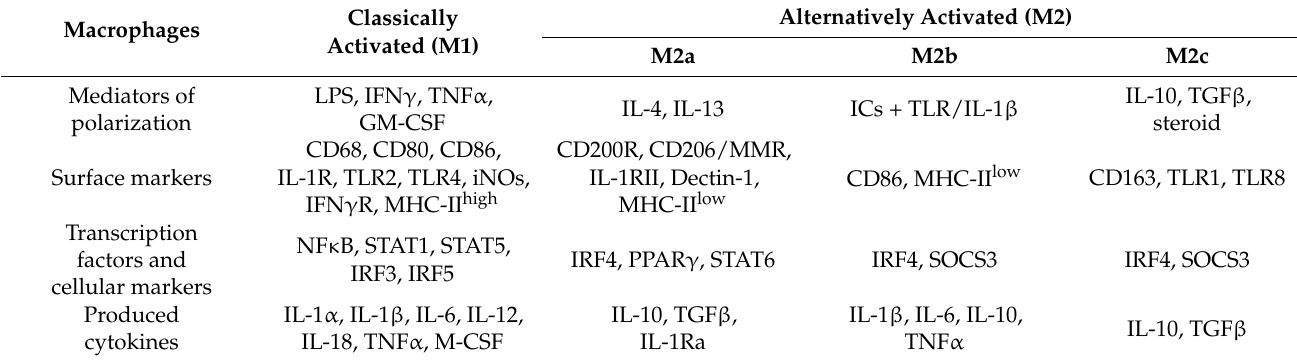
Table 1. Characteristics of monocyte and macrophage polarization in